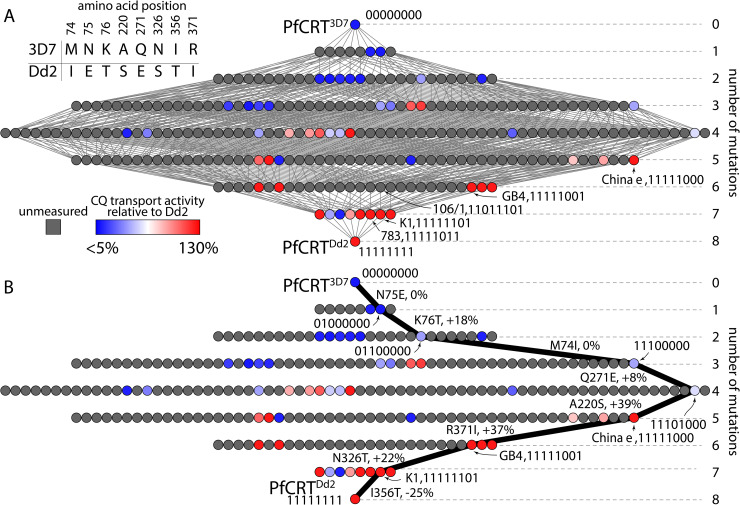
Only 52 of the 256 possible genotypes between PfCRT3D7 and the CQ-transporting PfCRTDd2 isoform have measured phenotypes.A) The table shows the amino acid residue differences between the wild-type (PfCRT3D7, 00000000) and mutant (PfCRTDd2, 11111111) isoforms of PfCRT. The network shows the complete set of genotypes between PfCRT3D7 and PfCRTDd2. Each node represents a different genotype with unique number and combination of the 8 amino acid residue differences between the two isoforms. Each edge connects genotypes that differ by a single mutation. Genotypes are in sorted combinatorial order, left to right, such that the second row contains 1000000, 0100000,…, 00000010, 00000001, the third row contains 11000000, 10100000, …, 00000101, 00000011, the fourth row contains 11100000, 11010000, …, 00001011, 00000111, etc. The gray nodes indicate PfCRT genotypes that have not had their CQ transport activities measured. The colors of the remaining nodes indicate experimentally determined CQ transport activities relative to the activity of PfCRTDd2 [24]. Values range from <5% (blue) to 130% (red). In addition to PfCRT3D7 and PfCRTDd2, the names and binary codes of five other field isoforms of PfCRT–“106/1”, “GB4”, “K1”, “783”, and “China e”–are indicated. B) One possible evolutionary trajectory from PfCRT3D7 to PfCRTDd2 that passes through only measured phenotypes. The mutations at each step are indicated next to the relevant edge, along with the effect on CQ transport activity. This trajectory passes through the PfCRTChina e and PfCRTK1 isoforms. Five of the eight steps increase CQ transport activity, two have no effect, and the final step causes a decrease.